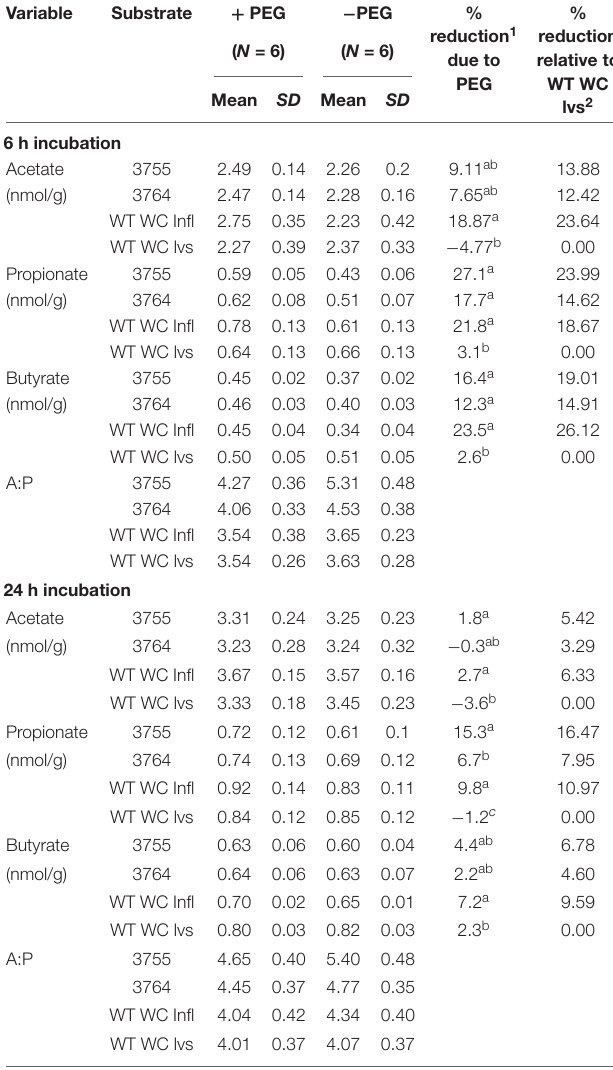
TABLE 1 | Production of ammonia, isovalerate, and isobutyrate after 6 and 24 h of incubation in rumen fluid with and without polyethylene glycol 6000 (PEG) in vitro § . Variable Substrate